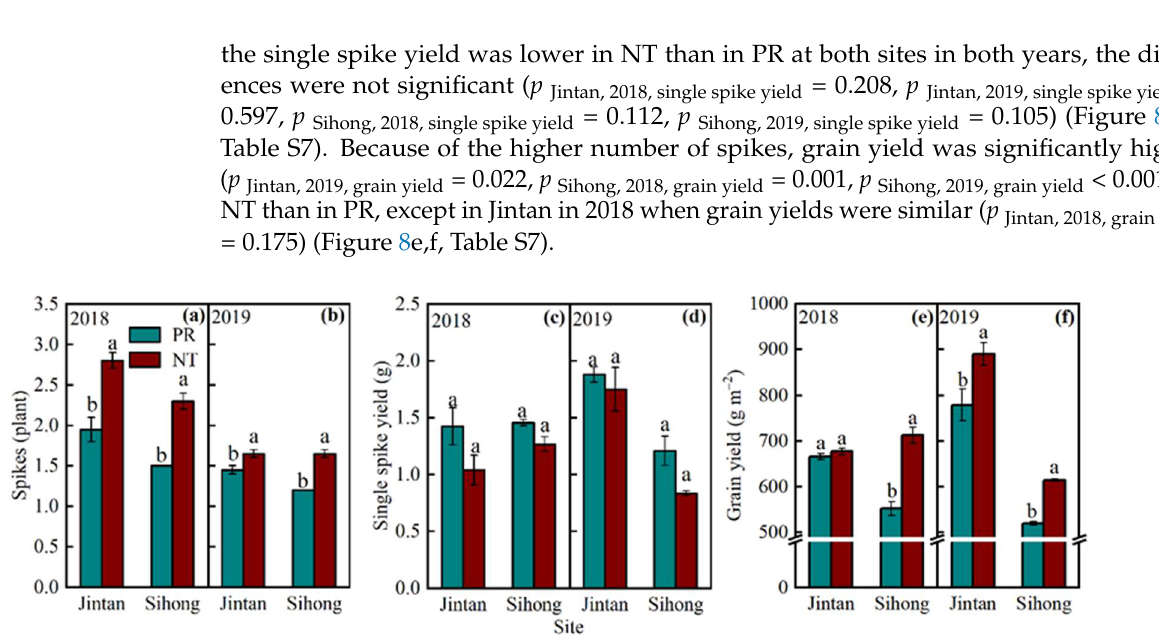
Figure 8. Effects of tillage practices on spikes per plant ( a , b ), single spike yield ( c , d ), and grain yield ( e , f ) of wheat at Jintan and Sihong in 2017–2018 and 2018–2019. Tillage methods included plow tillage followed by rotary tillage (PR) and no-tillage (NT). All values are presented as mean ± SE (3 replicates) with one standard error. Bars labeled with different letters indicate significant differences in tillage practices at the p < 0.05 level.